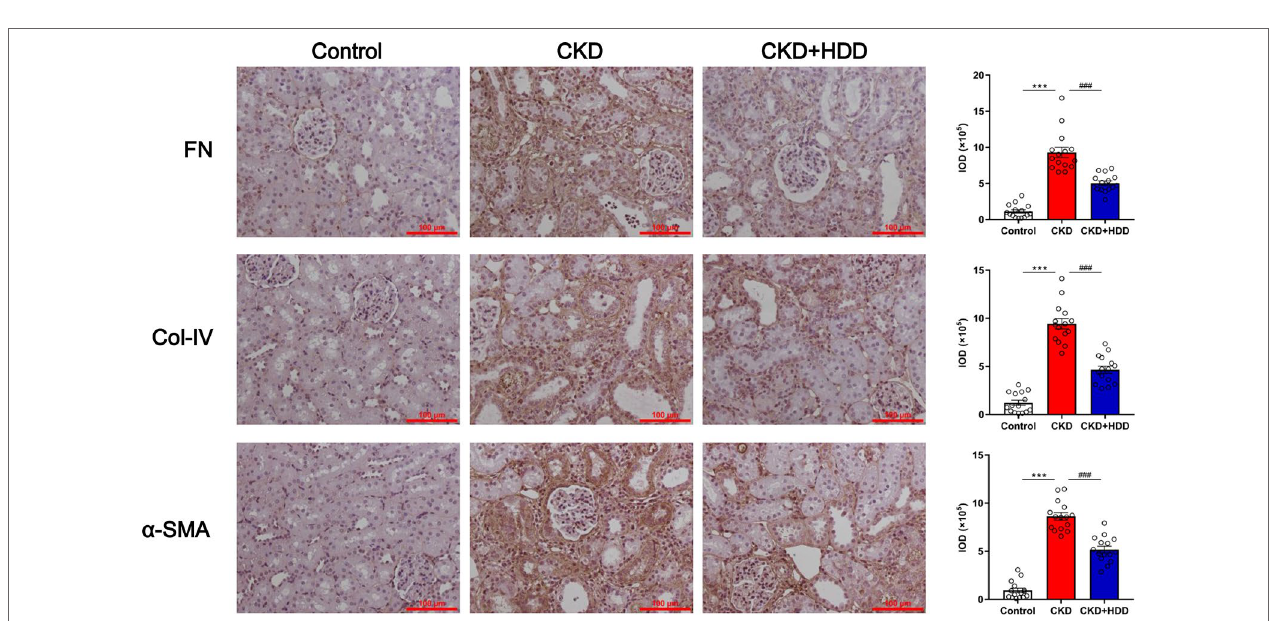
FIGURE 2 | HDD inhibited fibrotic markers expression in CKD rats. Data are presented as the means ± SEM, n = 3 rats per group (*** P < 0.001 compared with the control group; ### P < 0.001 compared with the CKD group).